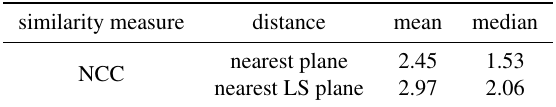
Figure 5. Zoom-in of Fig. 4 to the area of the TUM main campus (Number of tie points: